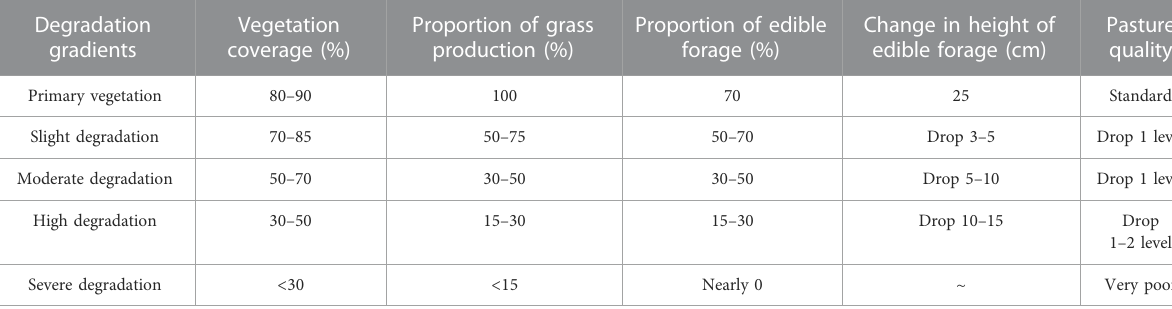
TABLE 1 Criteria for evaluating degraded grassland.